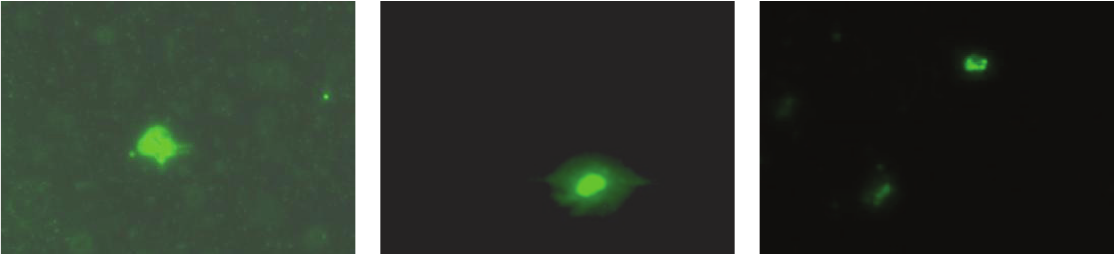
Figure 2: Indirect immunofluorescence demonstrating pax-6, isl-1, and pdx-1, from left to right, × 100.